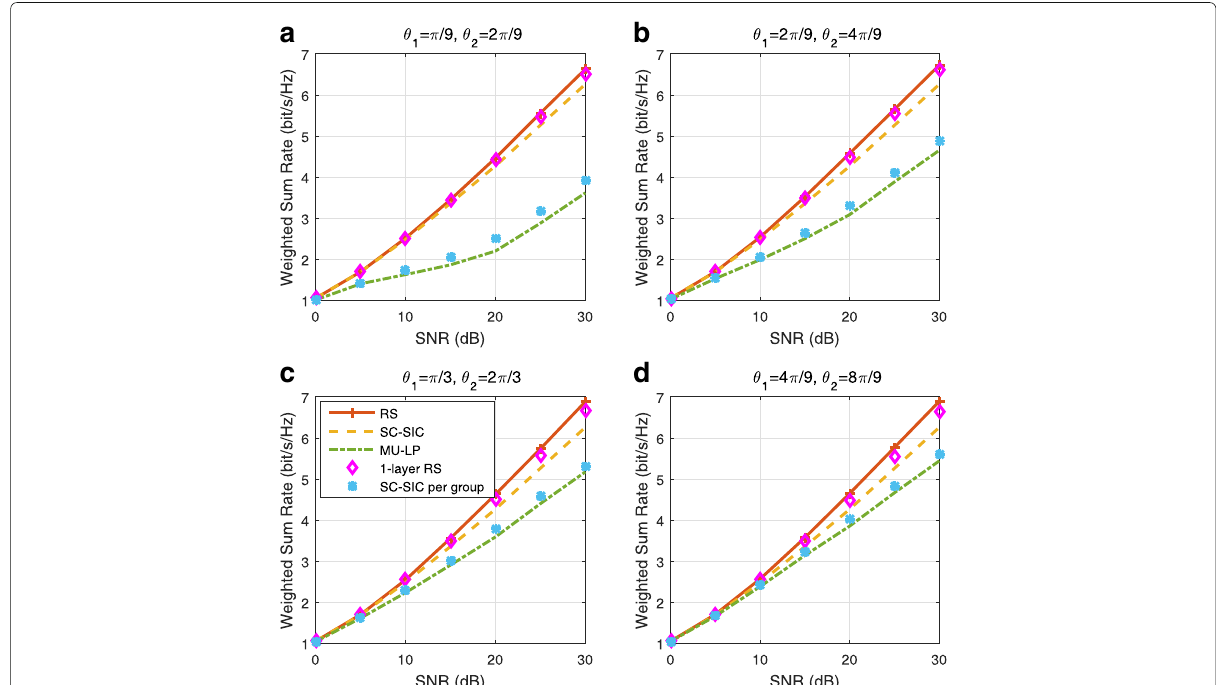
Fig. 54 Weighted sum rate versus SNR comparison of different strategies for overloaded three-user deployment with imperfect CSIT, γ 1 = γ 2 = 1, u 1 = 0.6, u 2 = 0.3, u 3 = 0.1, N t = 2, r th = [0.02,0.08,0.19,0.3,0.4,0.4,0.4] bit/s/Hz. a θ 1 = π/ 9, θ 2 = 2 π/ 9. b θ 1 = 2 π/ 9, θ 2 = 4 π/ 9. c θ 1 = π/ 3, θ 2 = 2 π/ 3.